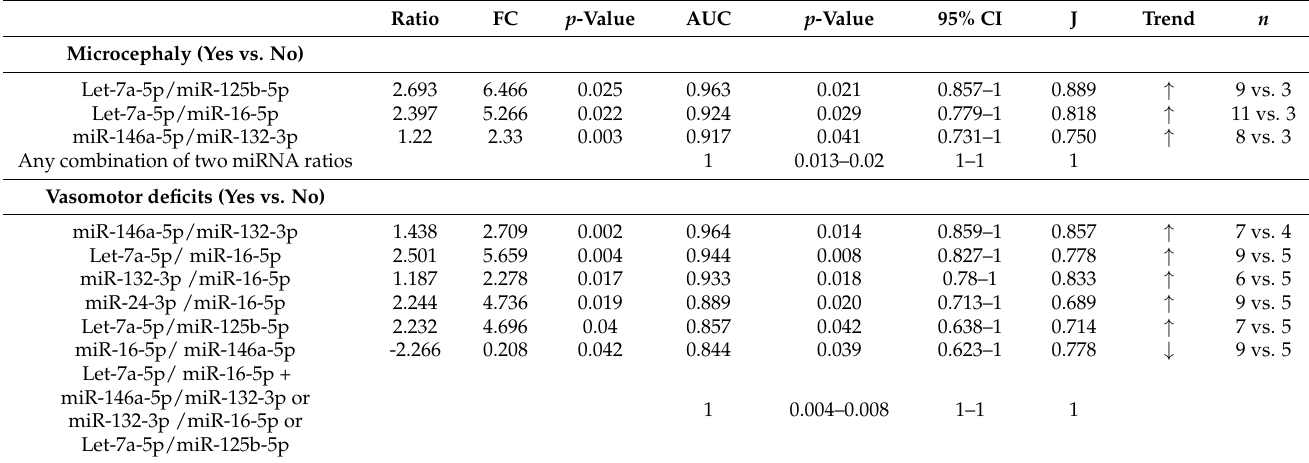
Table 5. Plasma miRNA ratios and performance as RTT stratification biomarkers. Ratio FC p -Value AUC p -Value 95% CI J Trend